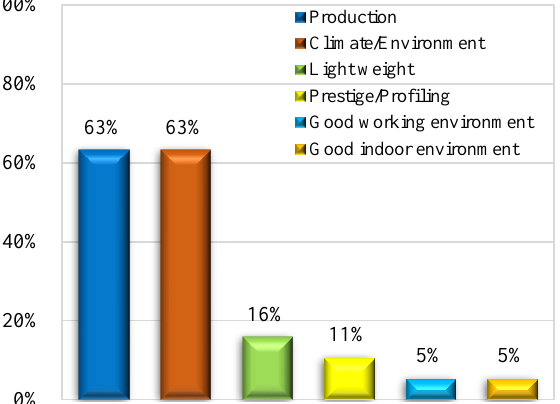
Figure 9. Comparison of advantages of constructing with wooden frames considered by ERs and UERs.